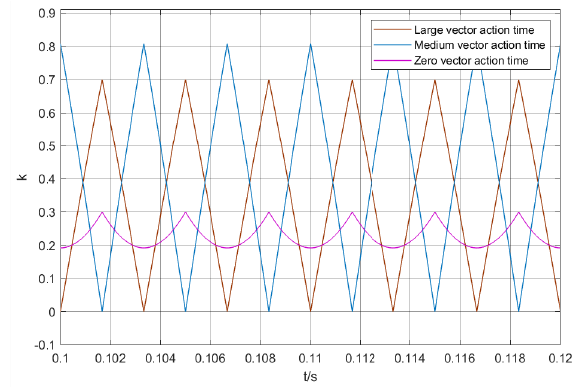
Figure 8. Action time of each vector when m = 0.7.